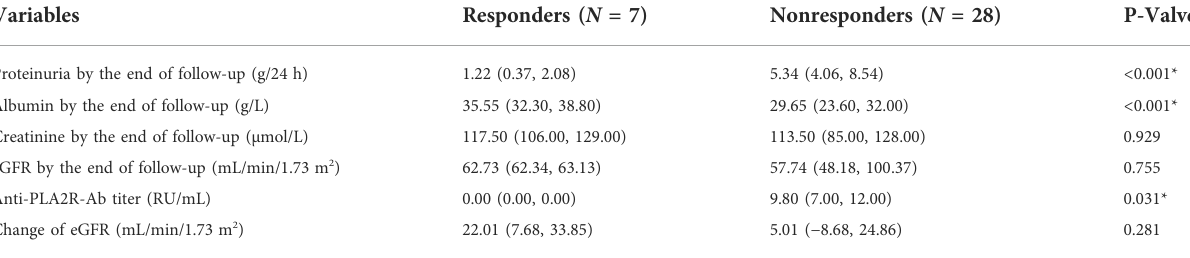
TABLE 4 Clinical characteristics of responders and nonresponders by the end of follow-up after rituximab treatment.